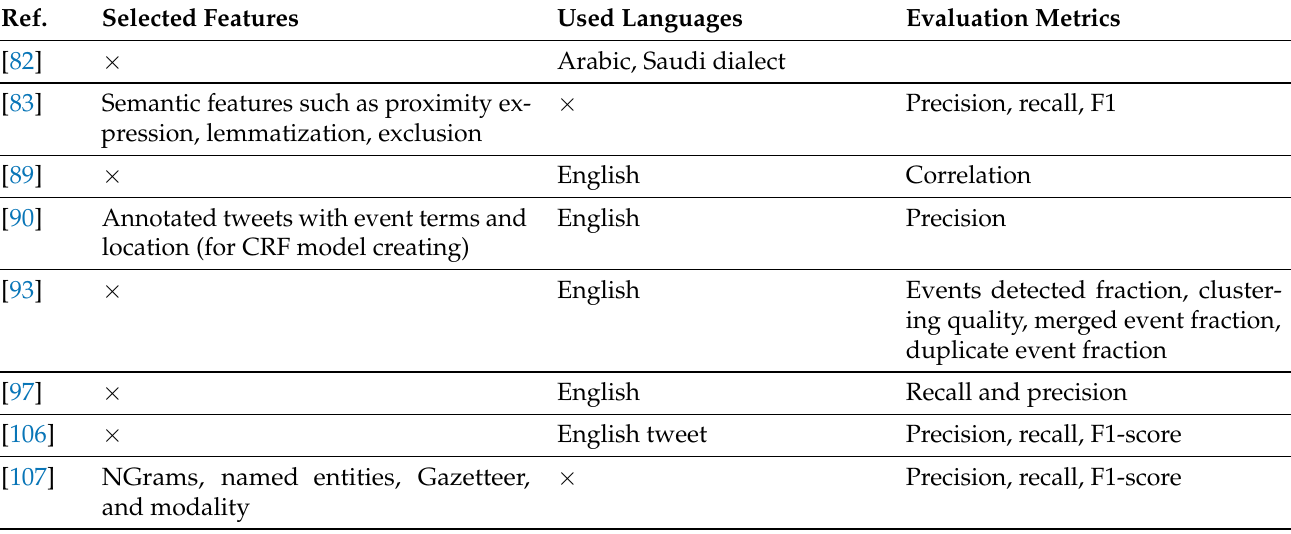
Table 3. A brief description of the selected features, studied languages, and evaluation matrices used in articles that applied other approaches.